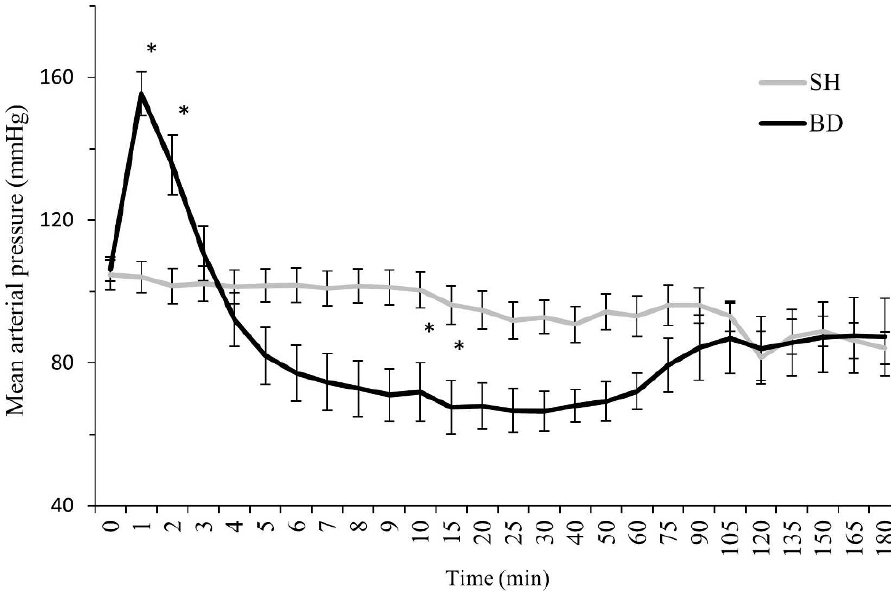
Figure 1 - Mean arterial pressure of brain-dead (BD, n =12) and sham-operated (SH, n =12) rats 180 minutes after the surgical procedure. The animals were monitored over time. The data are presented as the mean ¡ SEM. * p , 0.05 vs.